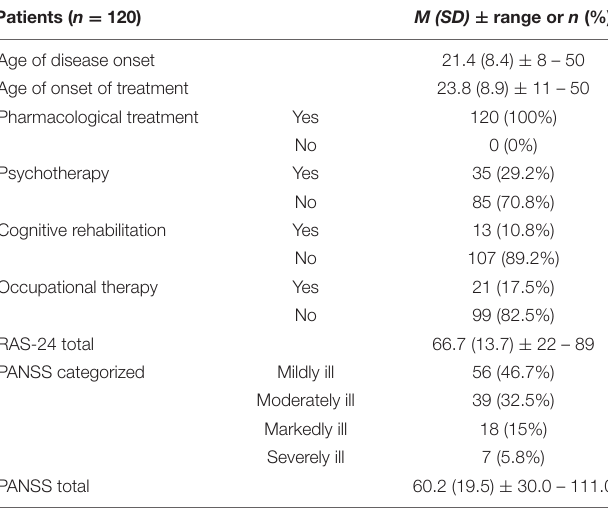
TABLE 1 | Clinical and treatment patients characteristics. Patients ( n =